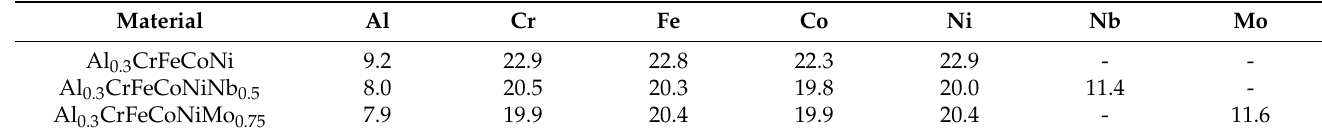
Table 4. Chemical composition of the HVOF-sprayed coatings in